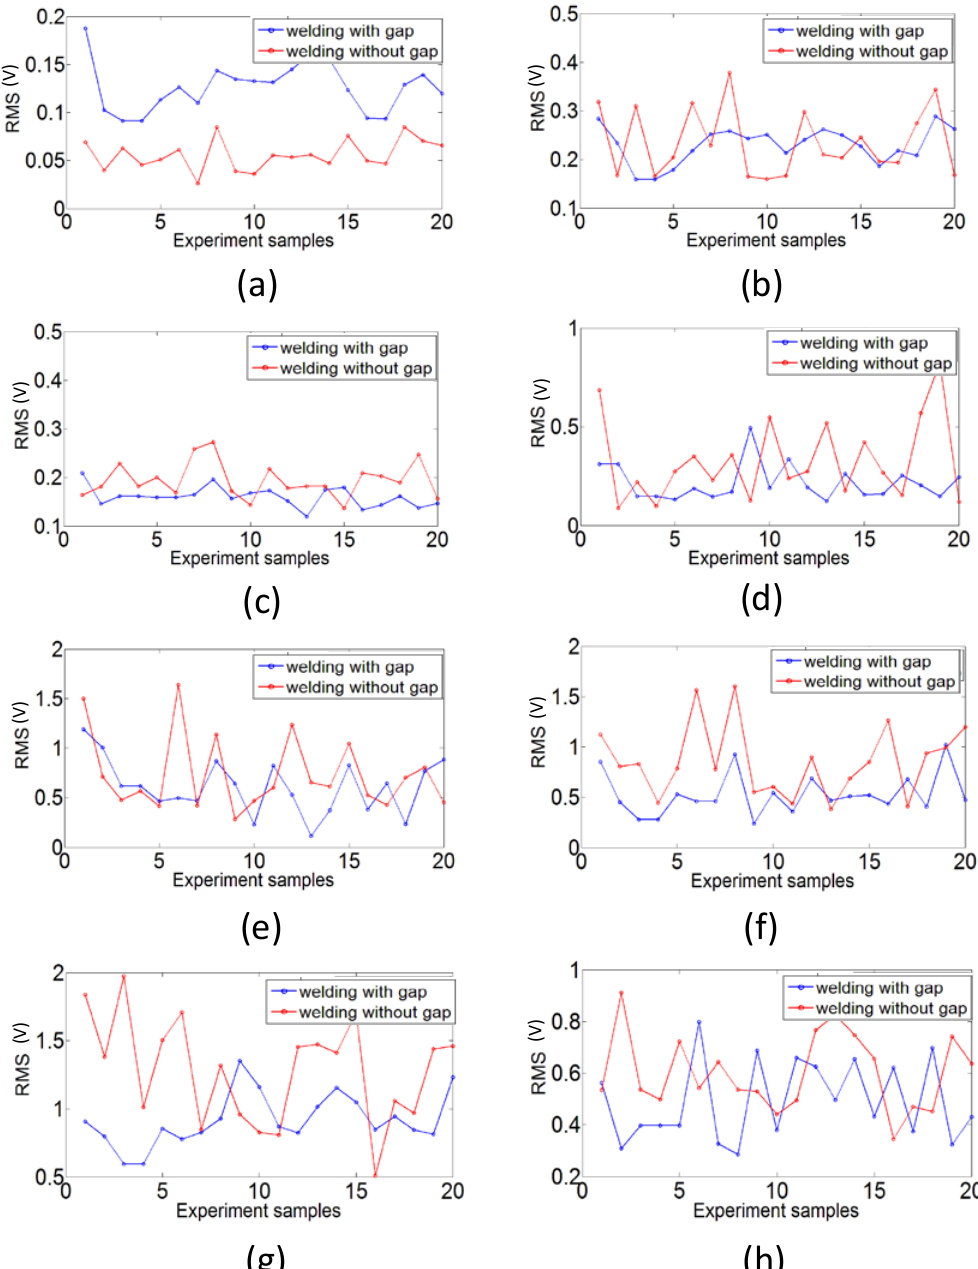
Figure 11. RMS values for each selected section with high- and low-joint-bonding strengths: ( a ) first section; ( b ) second section; ( c ) third section; ( d ) fourth section; ( e ) fifth section; ( f ) sixth section; ( g ) seventh section; ( h ) eighth section.